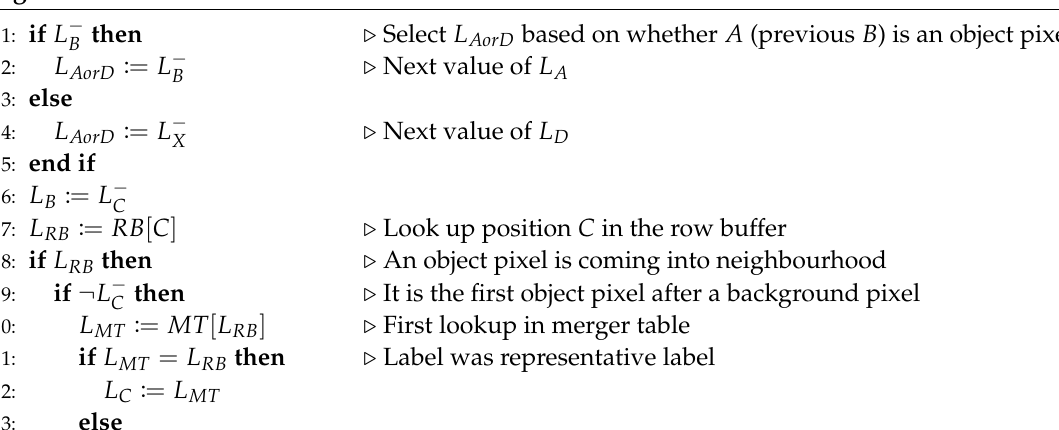
Algorithm 2 U PDATE N